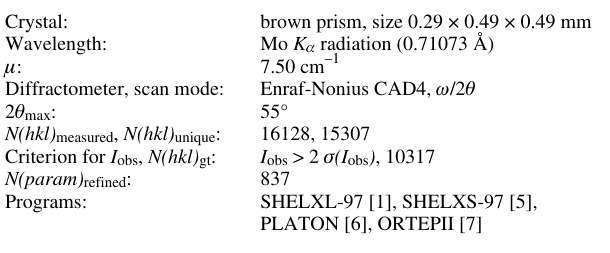
Table 1. Data collection and